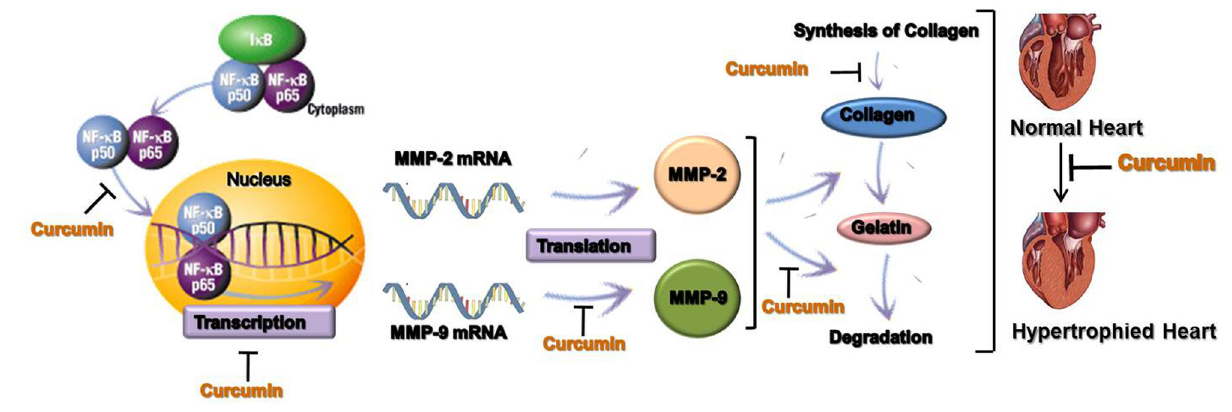
Figure S1. In vito cytotoxicity of curcumin. Cells treated with curcumin show about 100% viability till 8 µM urcumin concentration after which it decreases with increasing dose.